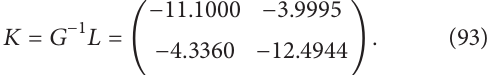
under the initial states 𝑥(𝑡) = [−0.2 0.2] [0.2 −0.2] 𝑇 , 𝑡 ∈ [−1.3 0] .